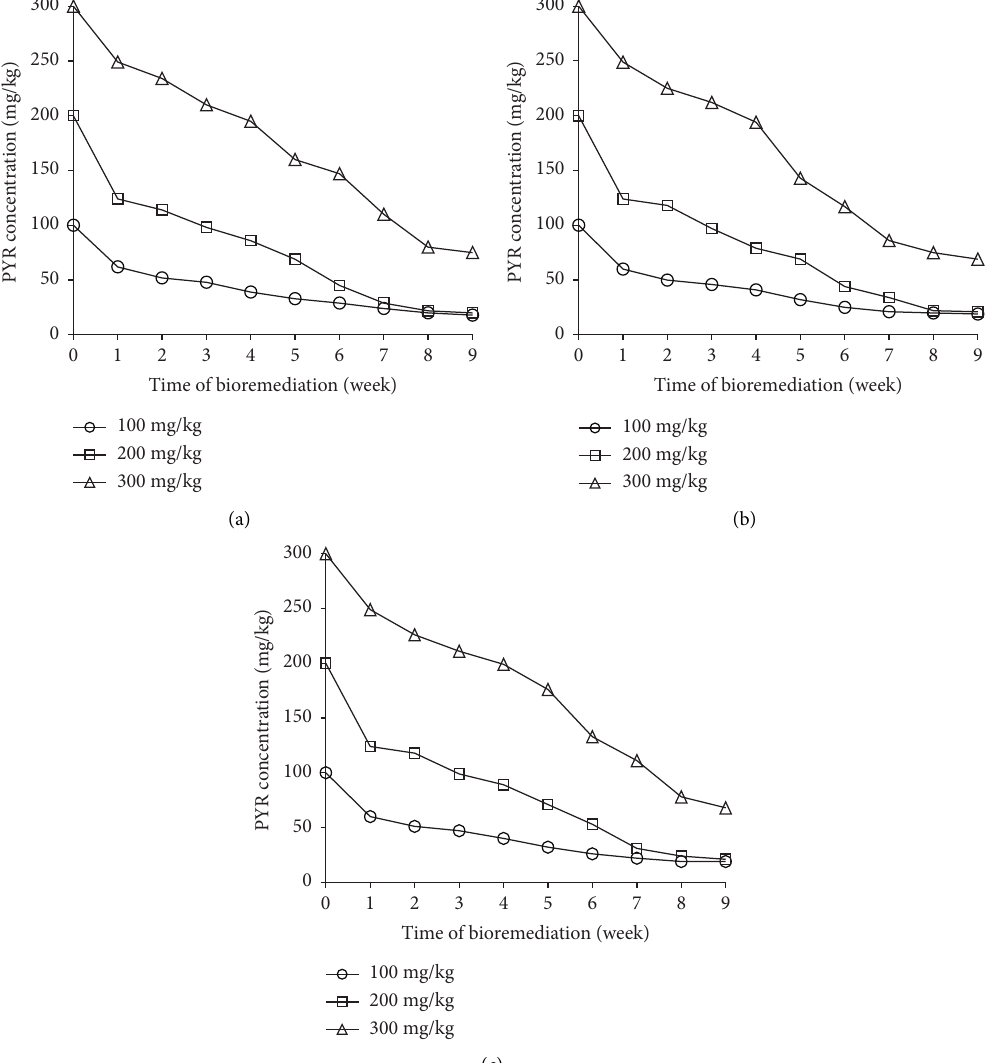
Figure 2: PYR concentrations in vermicompost of (a) 2%, (b) 4%, and (c) 6%.